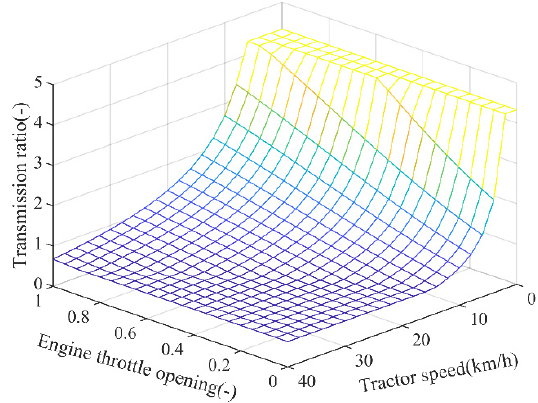
Figure 9. Map of HMT economic transmission ratio.